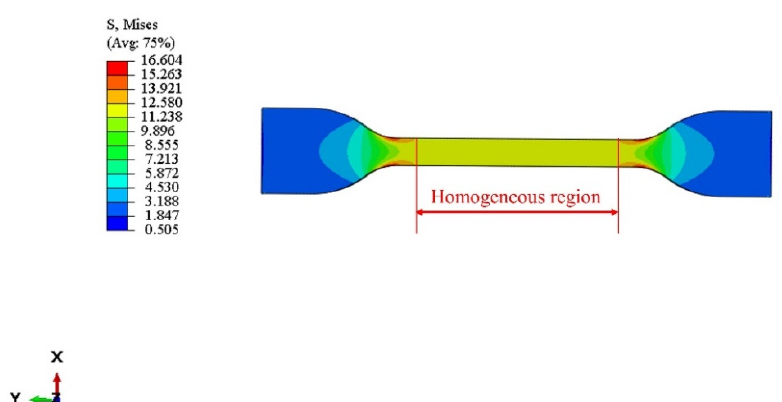
Figure 10. Contour map of the stress of the finite element analysis (FEA) of the C60 rubber specimen at 293 K.